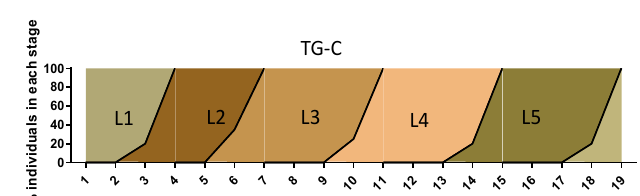
Figure 2. Normal growth and development in the transgenic lines. ( A ) No significant change in larval weight was observed between WT and transgenic animals. ( B – E ) No significant change in the stages of larval development in WT and TG-A, TG-B, and TG-C (L1, first instar; L2, second instar; L3, third instar; L4, fourth instar; L5, fifth instar). 3.3. Transgenic Silkworms Showed Higher Survival Rate after BmNPV Infection To determine whether transgenic silkworms are more able to survive viral infection than WT silkworms, the third instar larvae of the transgenic and WT lines were orally infected with BmNPV with 10 5 , 10 6 , and 10 7 OBs/larva, and mortality was monitored from 0 to 10 days post-infection. The survival rates of the TG-A, TG-B, and TG-C were approximately 97.22%, 100%, and 100%, respectively, at 10 dpi with 10 5 OBs/larva, whereas only 79.17% of WT silkworms were alive at 10 dpi (Figure 3A). Under 10 6 OBs/larva infection condition, the survival rate of WT silkworms was 63.89%, which was significantly lower than that of transgenic silkworms (TG-A, TG-B, and TG-C were 93.06%, 88.89%, and 94.44%, respectively) (Figure 3B). In the experimental group infected with 10 7 OBs/larva, all WT silkworms were dead by 7 dpi, whereas at 10 dpi, TG-A, TG-B, and TG-C exhibited 79.17%, 77.78%, and 73.61% of transgenic silkworms remaining alive, respectively (Figure 3C). WT silkworms infected with BmNPV had enhanced locomotor activity relative to infected transgenic animals, and at 60 hpi they became yellow and puffy with swelling of the segmental membrane (Figure 3D). In contrast, the TG silkworms appeared normal in shape, with no difference from healthy uninfected silkworms. A